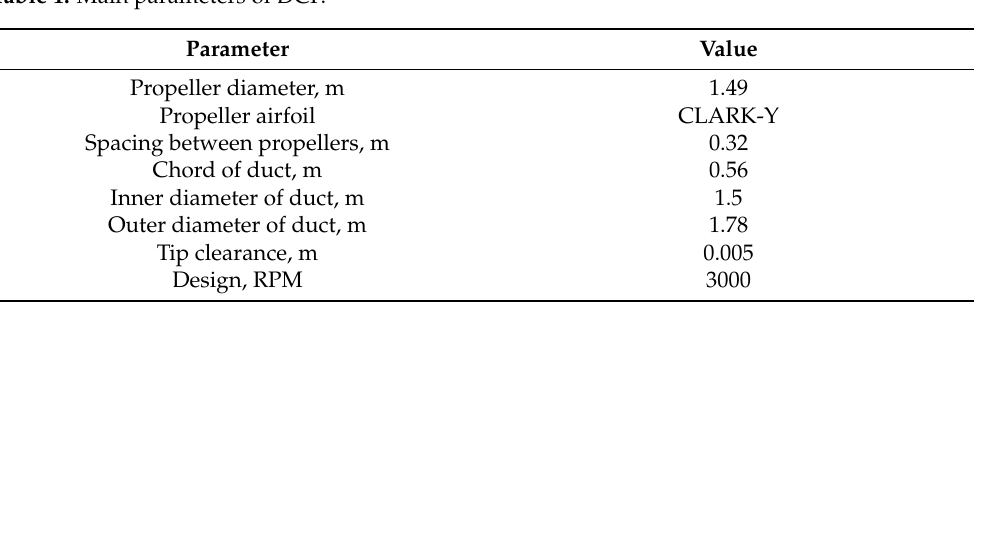
Table 1. Main parameters of DCP.